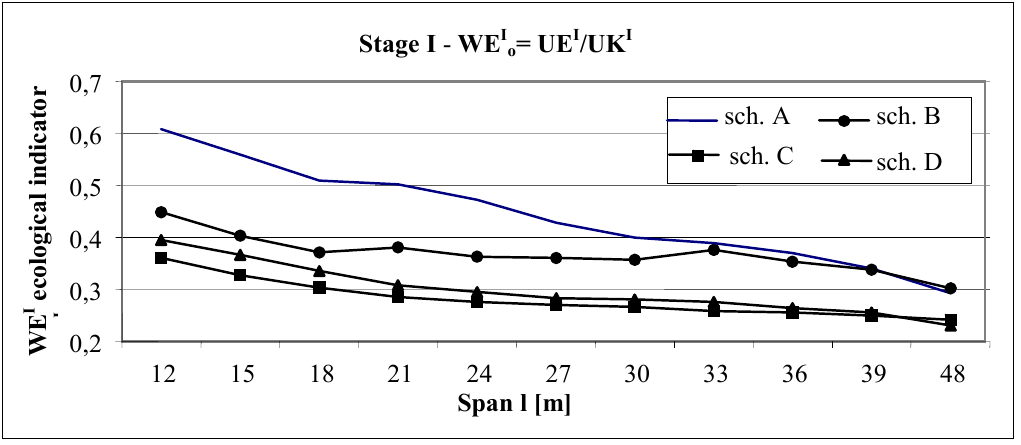
Figure 7. Ecological generalized WE Io index – cycle I of LCA. Optimal solutions are contained between the schemes of construction C—with the lowest values of the WE Io index (Equation (5))—and scheme A, which shows the highest level.